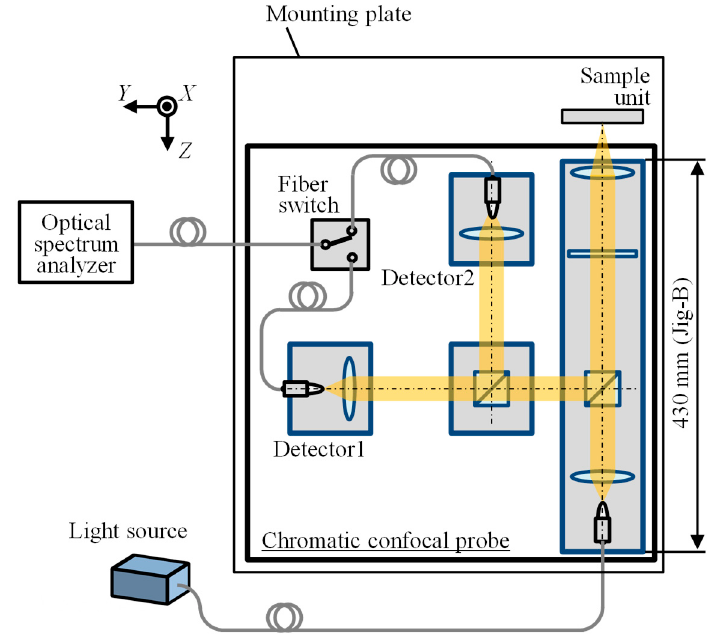
Figure 1. A schematic of the first prototype chromatic confocal measurement setup.